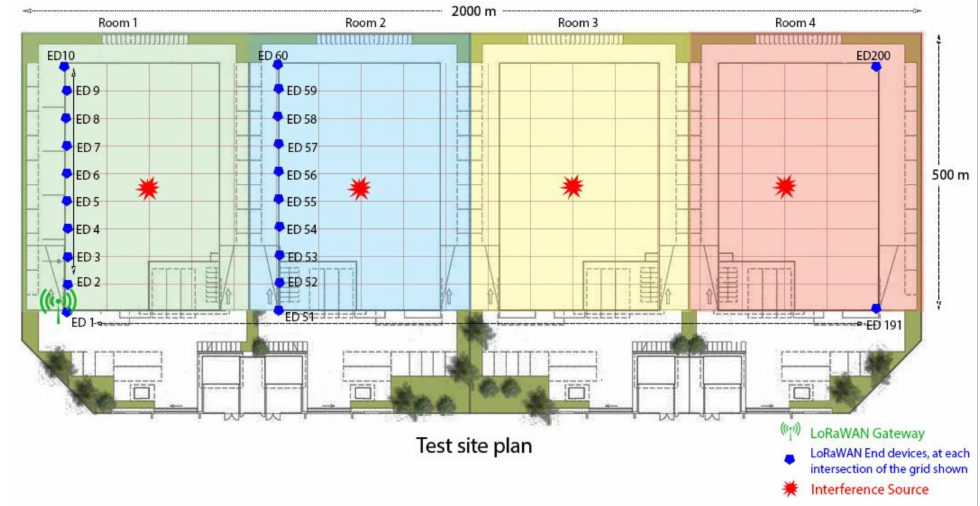
Figure 8. Map of the scenario showing node and interferer distribution.